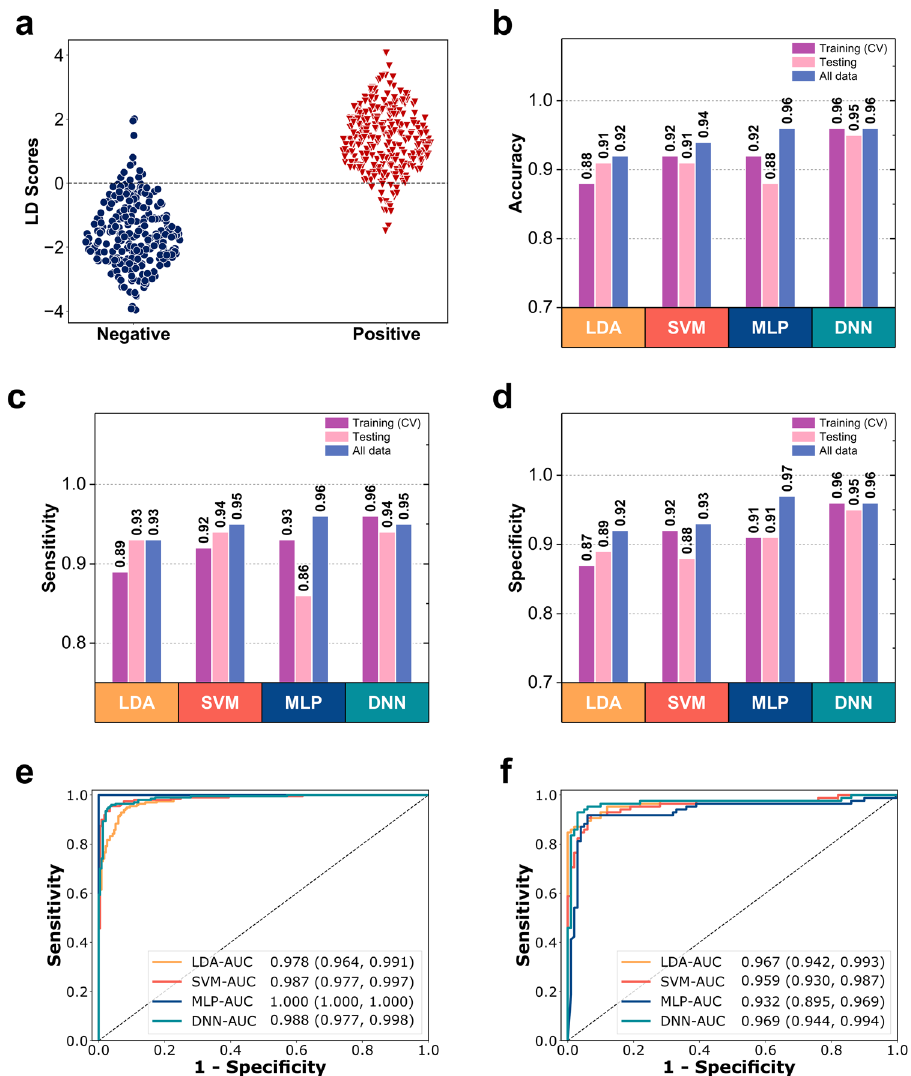
Fig. 5 Measured breath data analysis using machine learning. a Classi fi cation of two different exhaled breath samples (i.e., positive and negative COVID-19 samples) using the LDA model. b Overall accuracy (micro-averaged F1-score), c and d are sensitivity and speci fi city, respectively, of the training (10-fold cross-validation), testing, and all datasets obtained by four different machine learning algorithms (LDA, SVM, MLP, and DNN). e and f are the receiver operating characteristic (ROC) curves of the training and testing data, respectively, obtained by four different machine learning algorithms (LDA, SVM, MLP, and DNN). AUC and con fi dence intervals are also A sigmoid function was used for the last activation function with a binary cross-entropy loss. The applied procedure allowed us to employ 500 epochs, a batch size of 5, the fi rst hidden layer with 500 neurons and the “ relu ” activation function, the fi rst 0.1 dropout